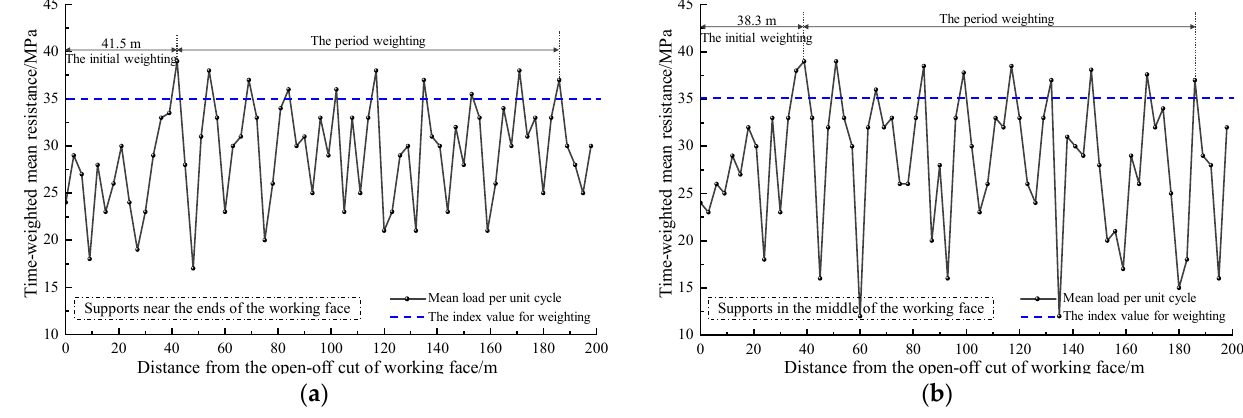
Figure 18. Observation of the time-weighted mean resistance of the support in 3215 working face. ( a ) Supports near the ends of the working face ( b ) Supports in the middle of the working face.